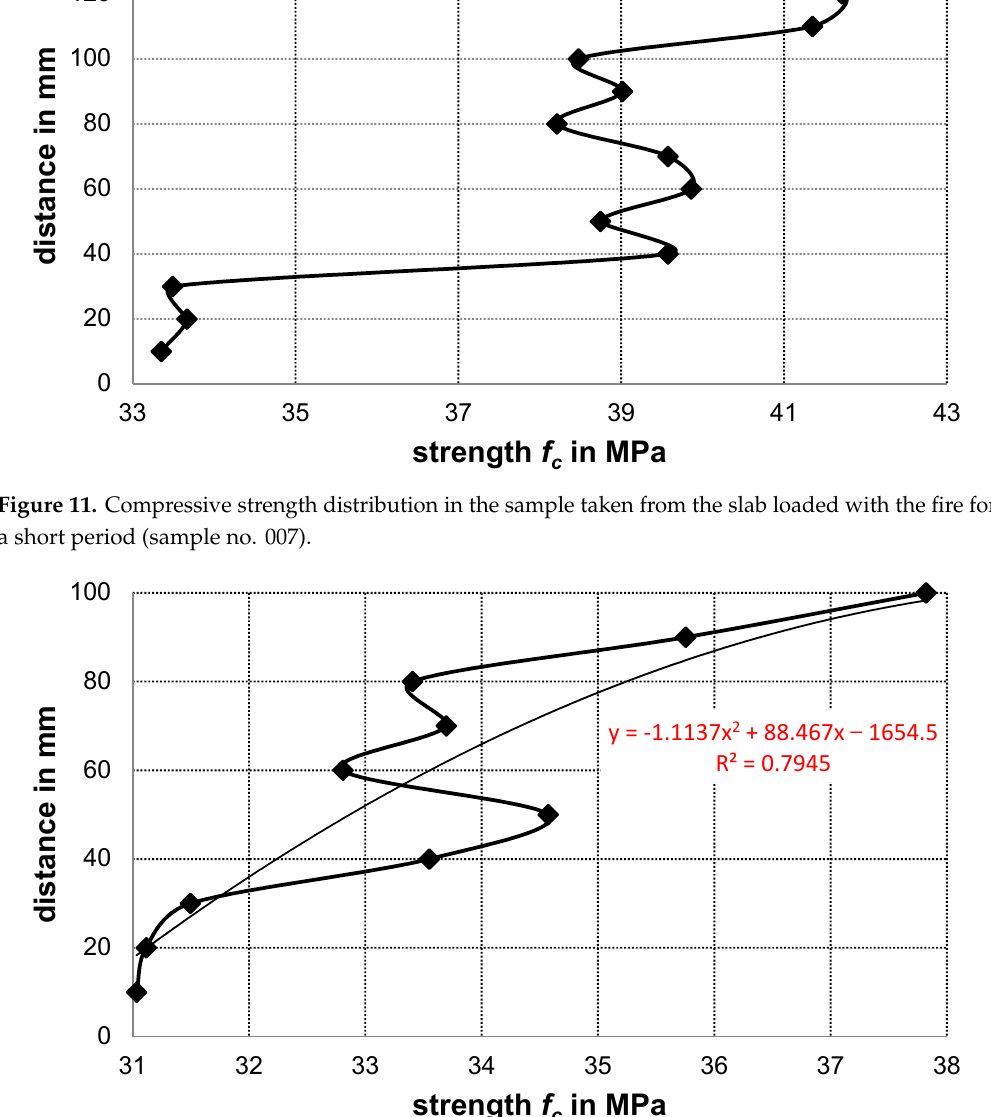
Figure 12. Distribution of compressive strength of concrete in the sample not exposed to the fire (sample no. 011/2).